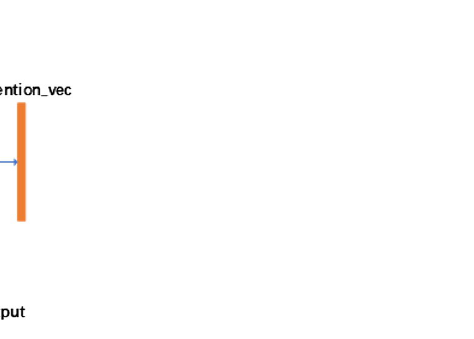
Figure 4. Attention mechanism of the ConvBLSTM-PMwA